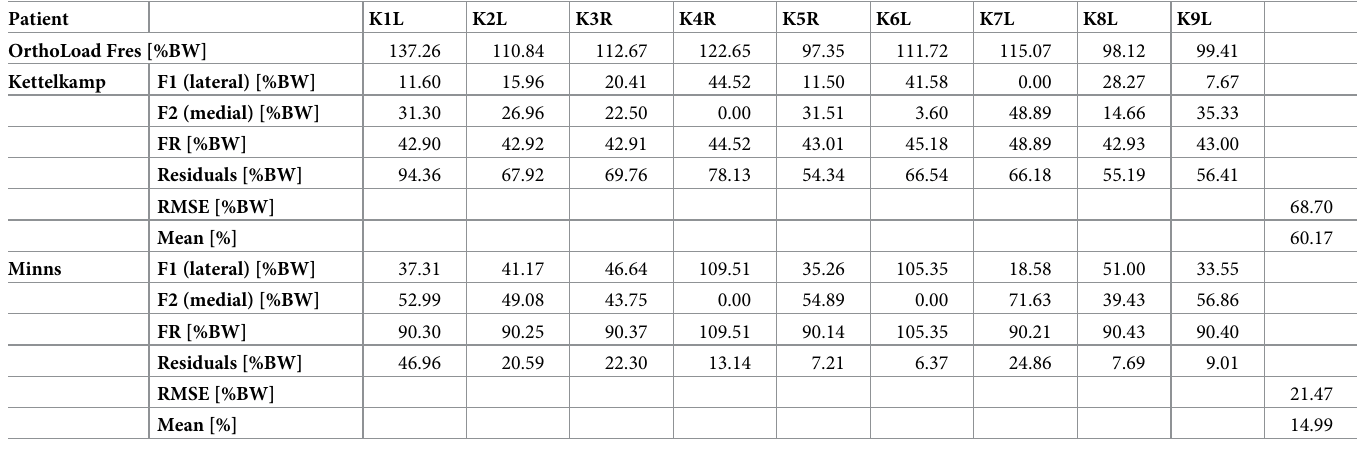
Table 4. Calculated and observed in vivo values during two-leg stance, split into medial, lateral and resultant contact forces F1, F2 and FR. Differences between FR and the average reference values are expressed in terms of RMSE. Forces in %BW, RMSE in %BW and mean differences in % of the average in vivo